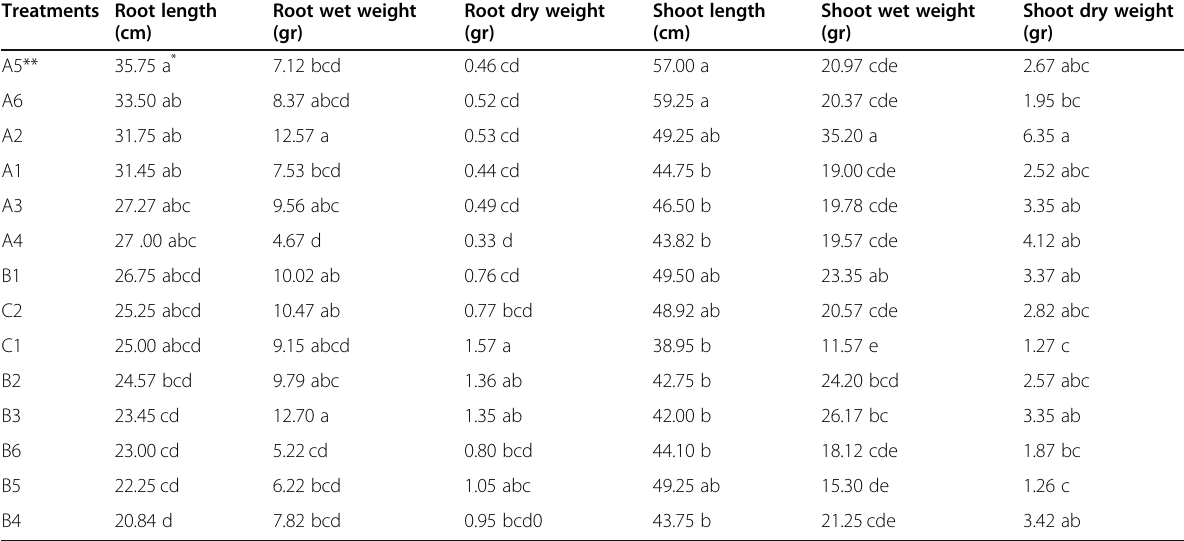
Table 3 Mean comparison of plant growth factors in greenhouse experiment Treatments Root length